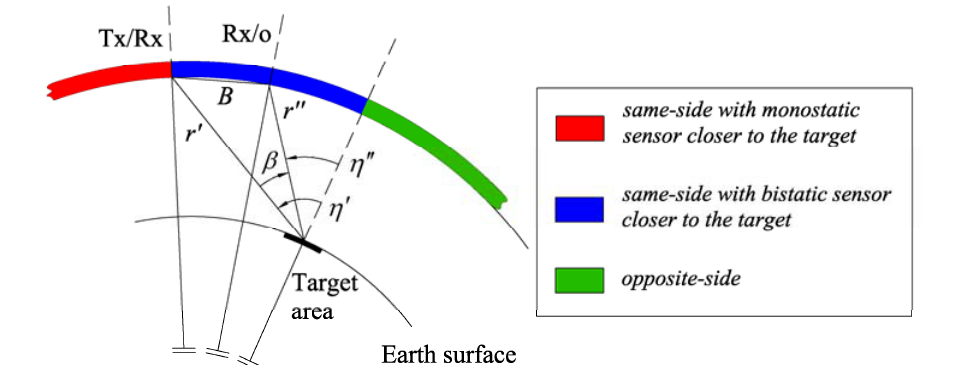
Figure 1. Observation strategies for monostatic-bistatic acquisition. The transmitting-receiving (Tx/Rx) and the receiving-only (Rx/o) antennae are supposed to operate at the same altitude in parallel trajectories (not to scale for